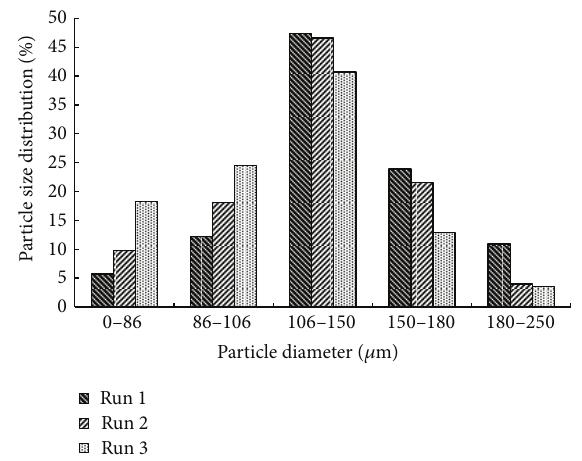
Figure 2: Product size distribution of pulverized biomass as a function of rotor speed of advanced crusher.